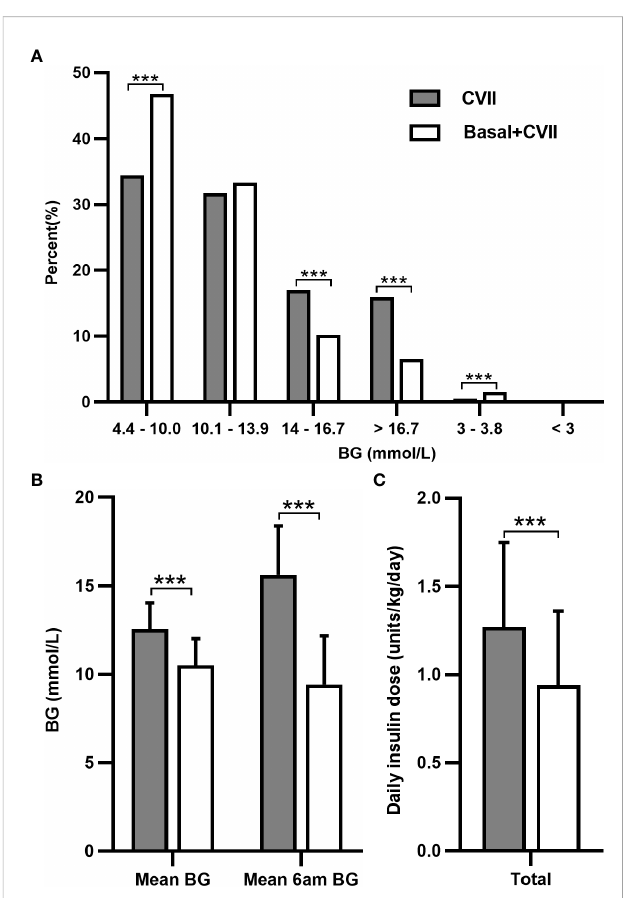
FIGURE 1 Analysis of the glycemic control and daily insulin dose after adding basal insulin to CVII therapy in 46 patients after total pancreatectomy during postoperative parenteral nutrition. Changes in the percentage of glucose data (A) , mean BG, mean 6 am BG (B) , and daily insulin dose (C) . CVII, continuous intravenous insulin infusion. BG, blood glucose. Data are presented as mean ± SD. *** P <